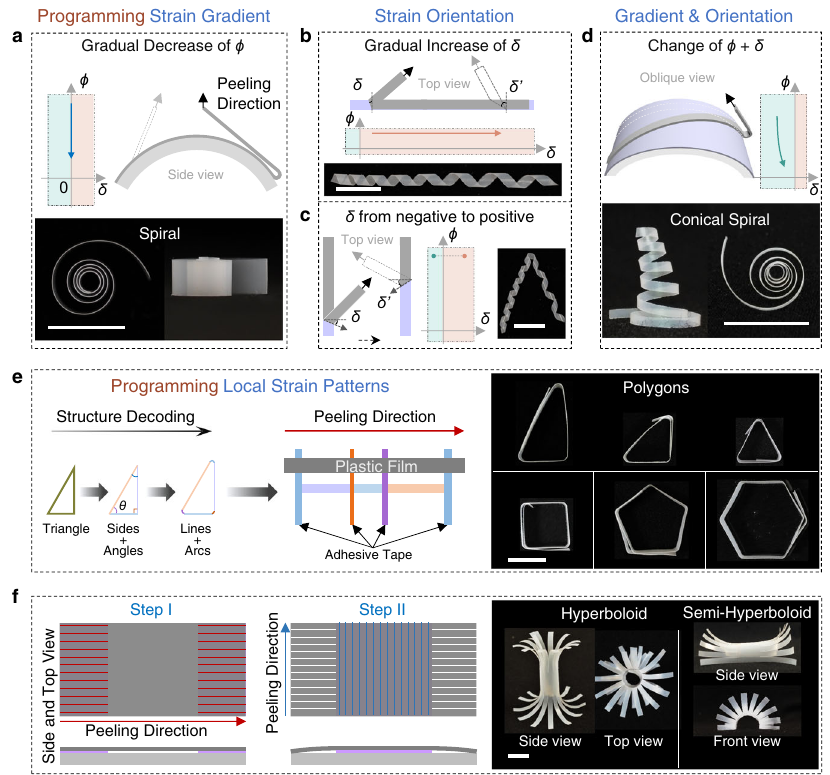
Fig. 3 | Peeling plastic fi lms with pre-set parameters and methods results in complexstructures.a Plastic fi lmspeeledfromanarcuatesurfacewithagradually changing peeling angle ( ϕ ) result in spiral-like structures. Top: schematic showing the peeling process. Bottom: top view (left) and side view (right) photographs of the spiral-like structure. b Plastic fi lms peeled with gradually increasing deviation angle ( δ ) form cylindrical helices with gradually increasing pitch. Top: schematics showing the peeling process with ϕ of ~180°. Bottom: photographs of the helices. c Plastic fi lms peeled with δ changing from negative to positive (left schematic) form cylindrical helices with different chirality (right photograph). Schematics show top views of the peeling process at ϕ of 180°. In a – c schematics, the dotted outlines and gray arrows indicate the fi nal state of the peeling process. d Films peeled with simultaneously changing ϕ and δ form conical spirals. Top: oblique view schematic of the peeling process, where the plastic fi lm (gray) adhered at an angle to the generatrix of the arcuate substrate. Bottom: side view (left) and top